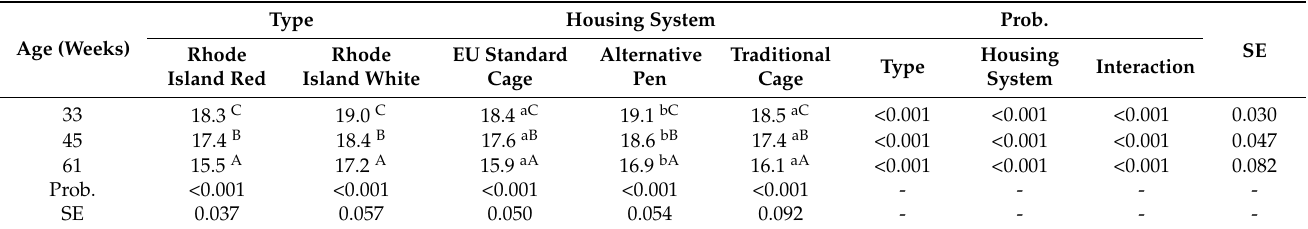
Table 2. Effect of type and housing system on the total plumage score of non-beak-trimmed Rhode Island hens.